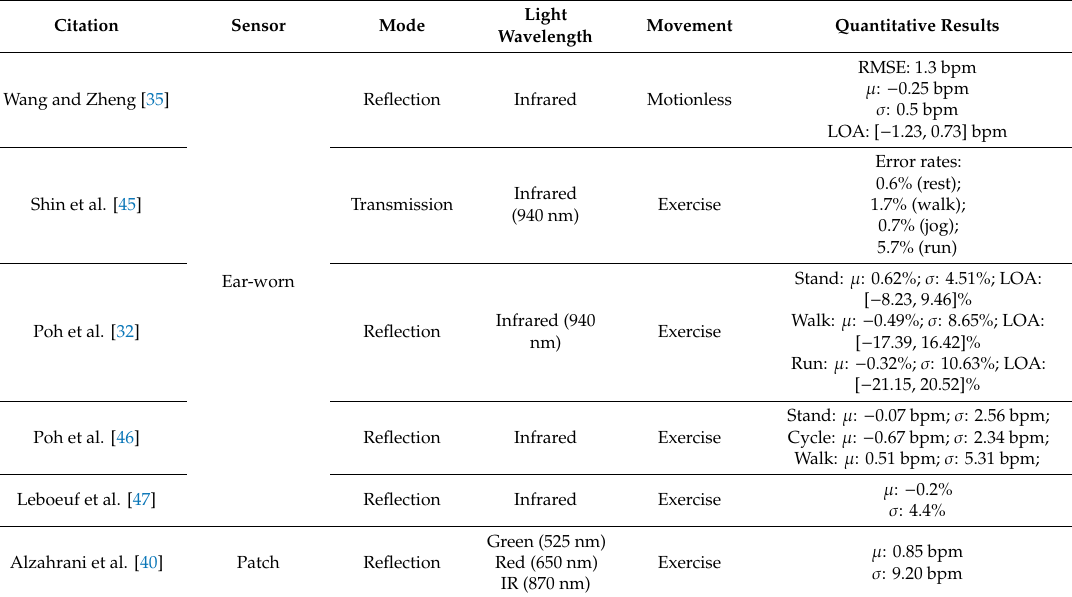
Table 3. Summary of ear-worn and patch PPG sensors for HR